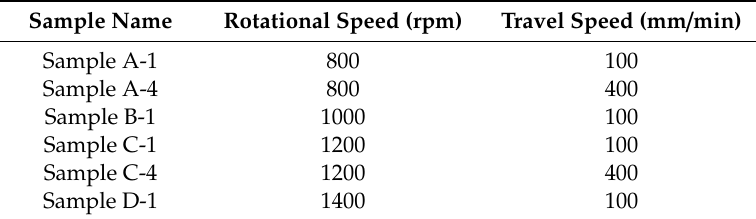
Table 2. Sample name and welding parameters of similar joints of Al6061(T6).